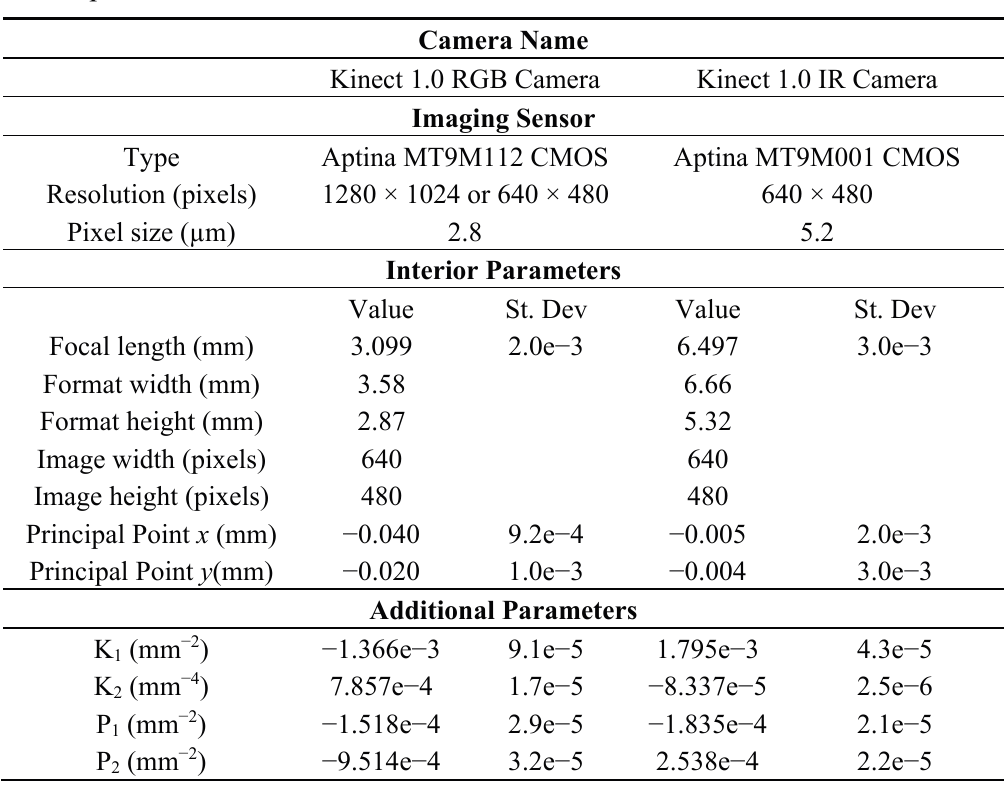
Table 2. Sensors and IO parameters of RGB and IR cameras estimated during the camera calibration procedure for Kinect 1.0.